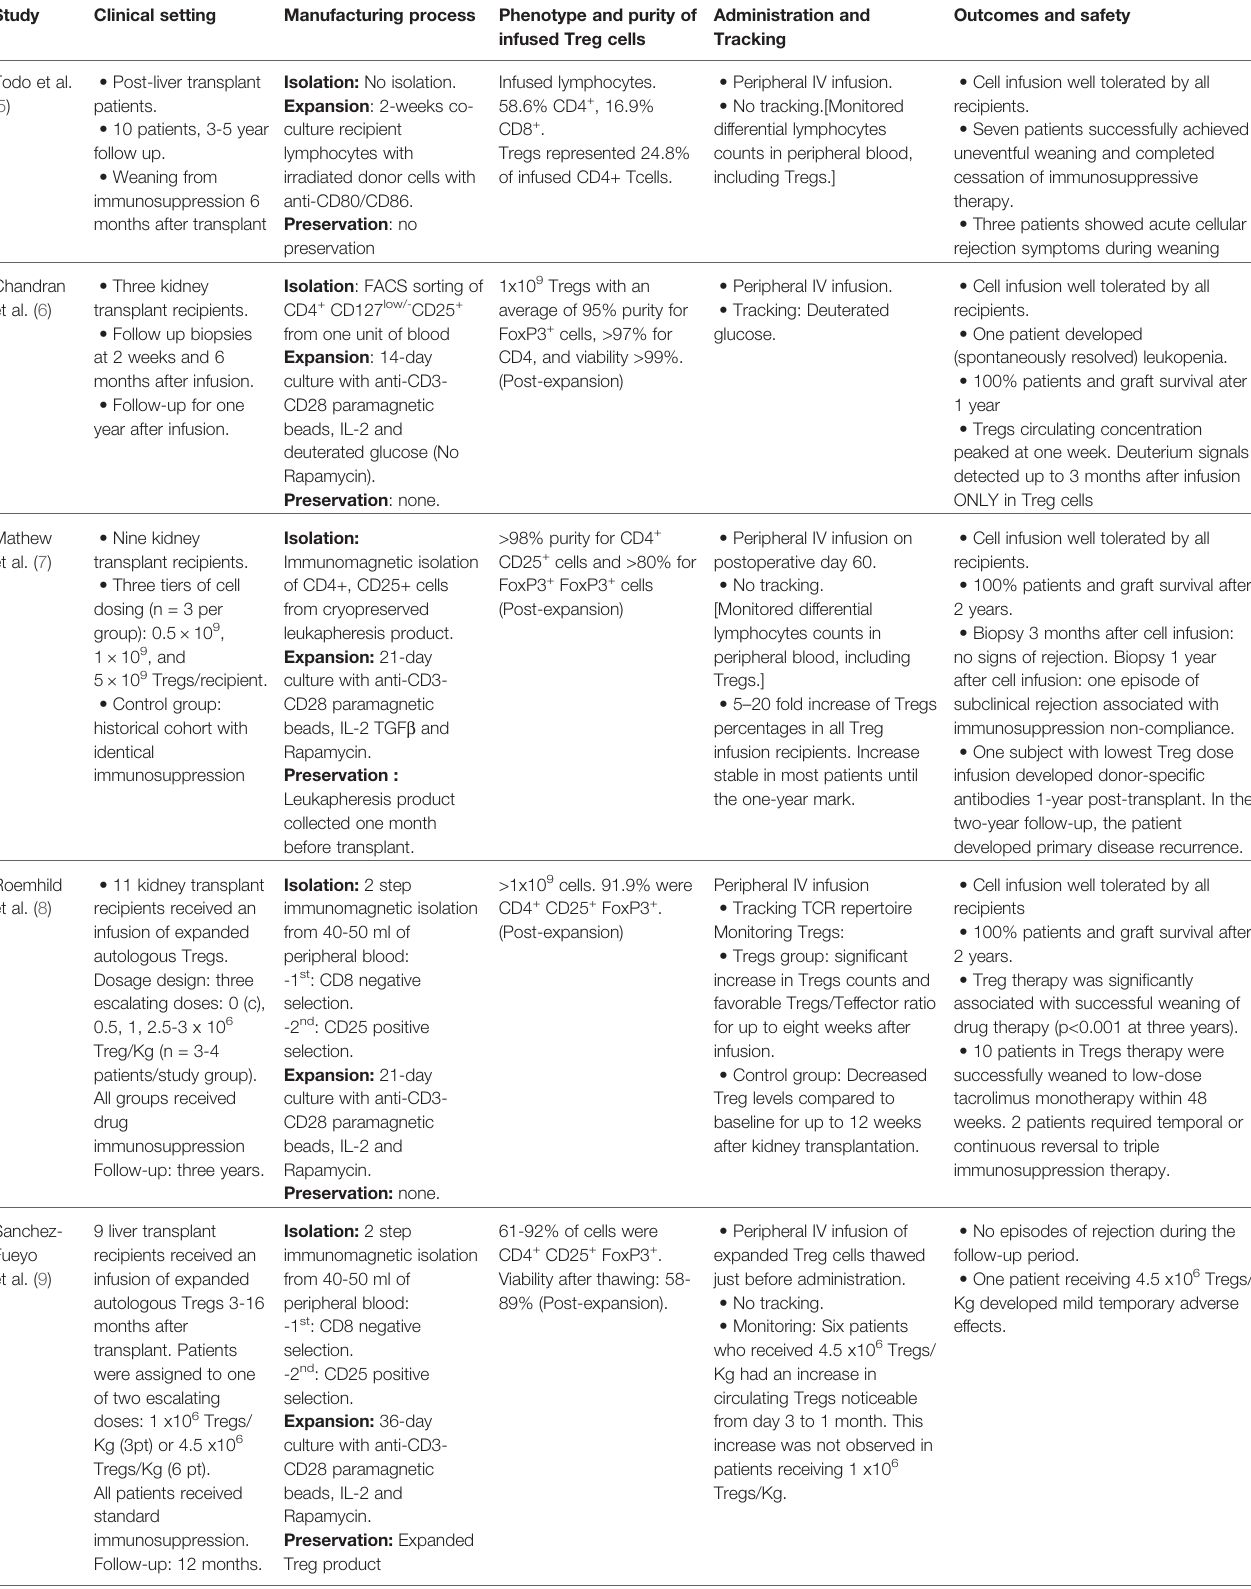
TABLE 1 | Published studies evaluating Treg transfer therapy after solid organ transplantation. Study Clinical